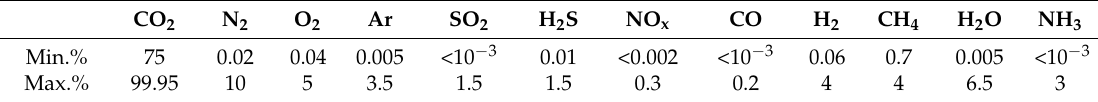
Table 5. Minimum and maximum mole percentages of typical impurities in CO 2 streams